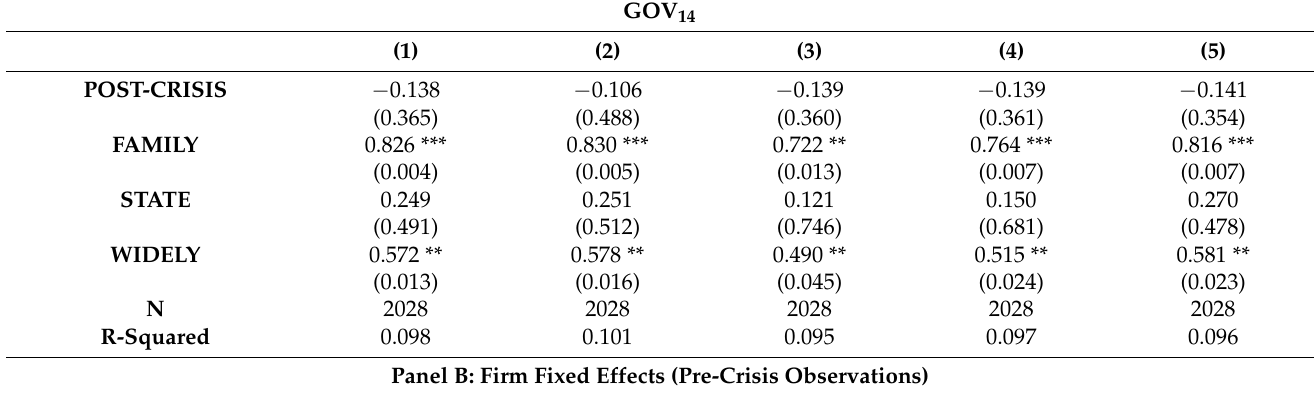
Panel B: Firm Fixed Effects (Pre-Crisis Observations)